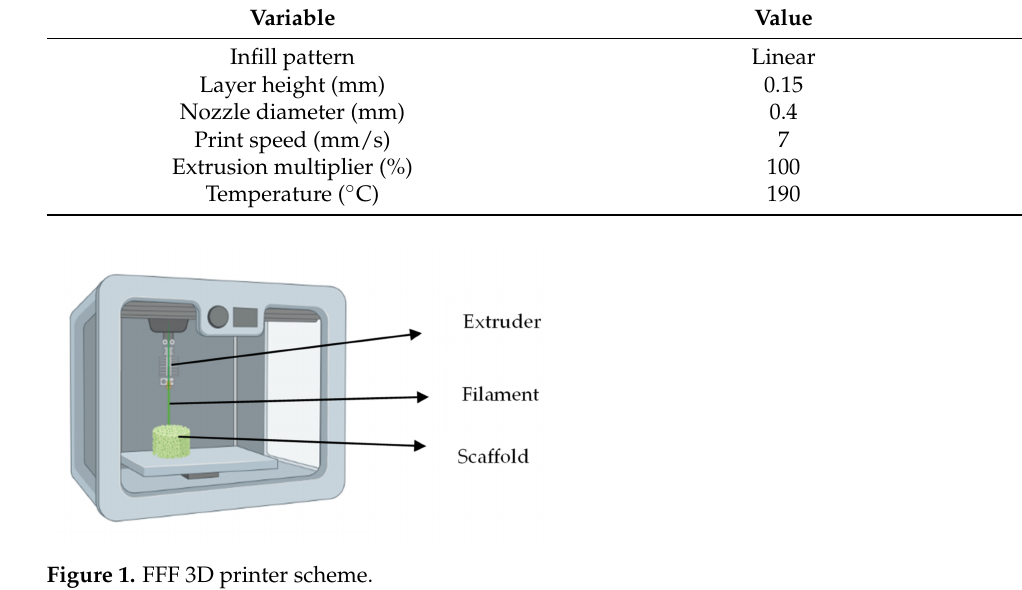
Table 1. 3D printing parameters.